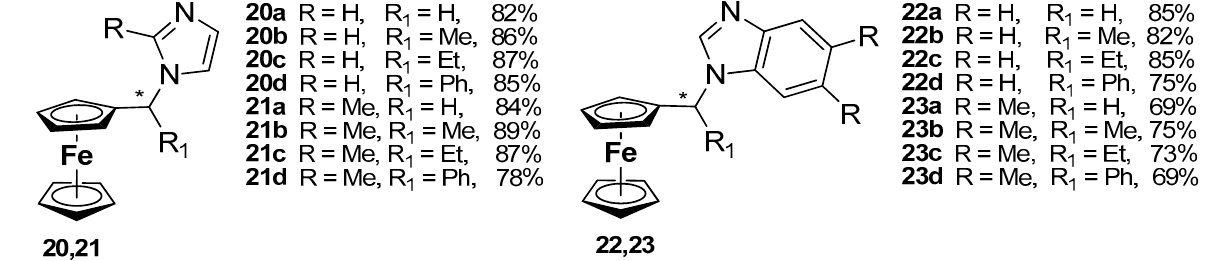
Figure 11. Ferrocenylalkyl imidazoles ( 20a – d , 21a – d ) and ferrocenylalkyl benzimidazoles ( 22a – d , 23a – d ) via oxalyl diimidazole; yields are given in %; an asterisk in structures means a stereogenic